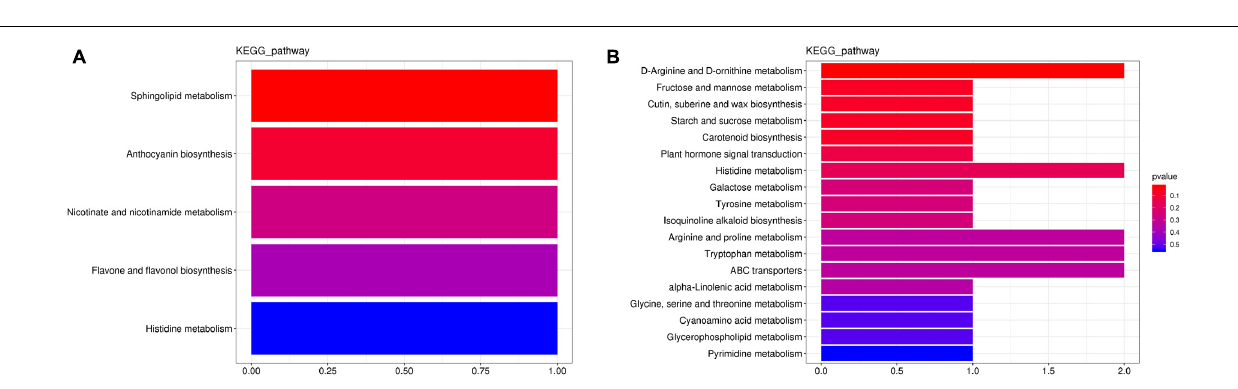
FIGURE 4 | Kyoto Encyclopedia of Genes and Genomes pathways’ enrichment for (A) the CK vs. B comparative grouping and (B) the D vs. DB comparative